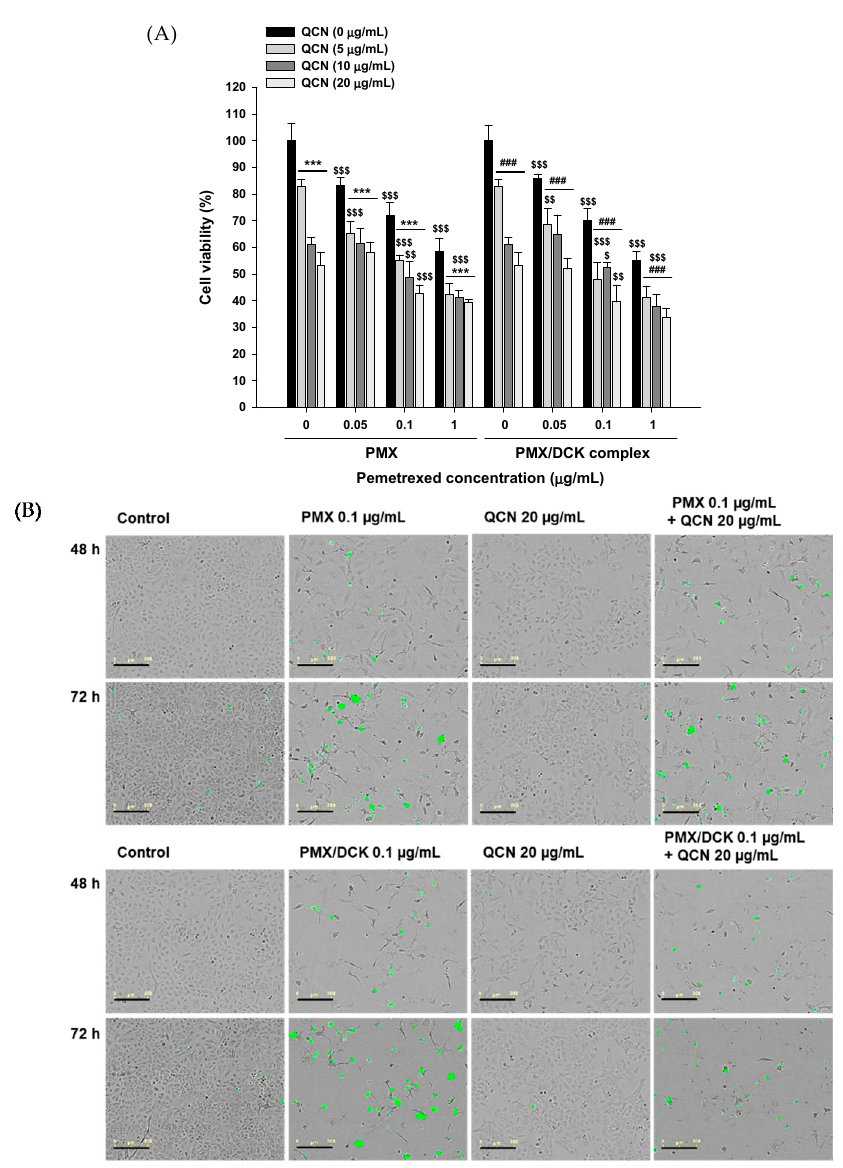
Figure 2. ( A ) In vitro cytotoxic effects of PMX, PMX/DCK, QCN, and combinations of PMX or PMX/DCK with QCN on A549 cells after incubation for 48 h ( n = 5). *** p < 0.001 compared with PMX alone at the same concentration. ### p < 0.001 compared with PMX/DCK alone at the same concentration equivalent of PMX. $ p < 0.05, $$ p < 0.01, $$$ p < 0.001 compared with QCN alone at the same concentration; ( B ) Live cell fluorescence images of caspase-3/7 activity at 48 and 72 h after treatment of A549 cells with PMX, PMX/DCK, QCN, and combinations of PMX or PMX/DCK with QCN. Scale bar represents 200 µm.